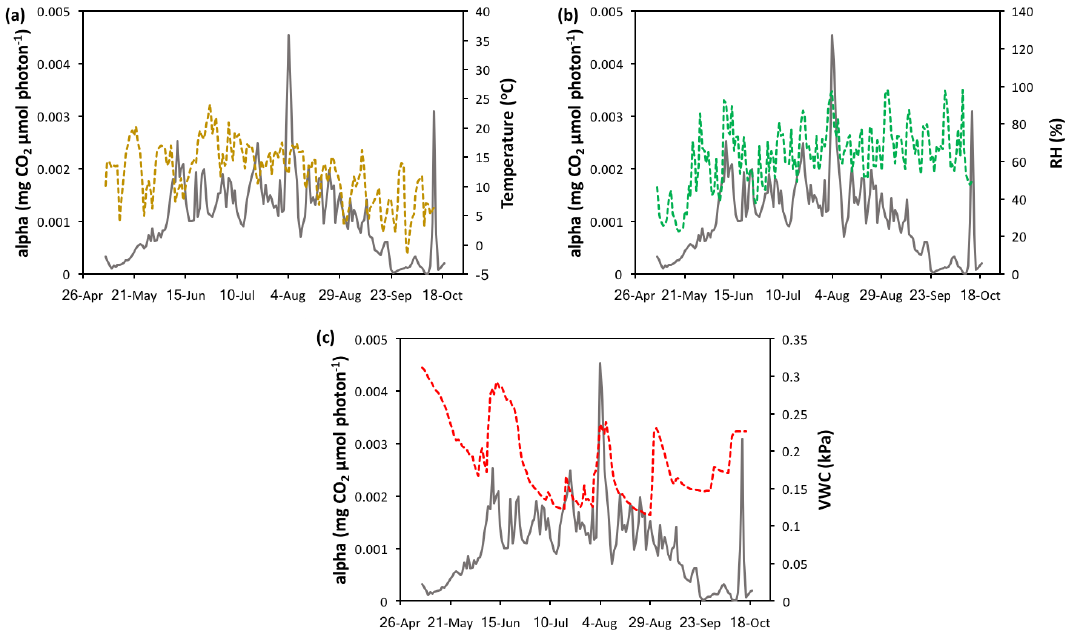
Figure A2. Time series of apparent quantum yield and ( a ) temperature, ( b ) relative humidity (RH), and ( c ) soil volumetric water moisture (VWC). Apparent quantum yield values were derived from eddy covariance measurements.